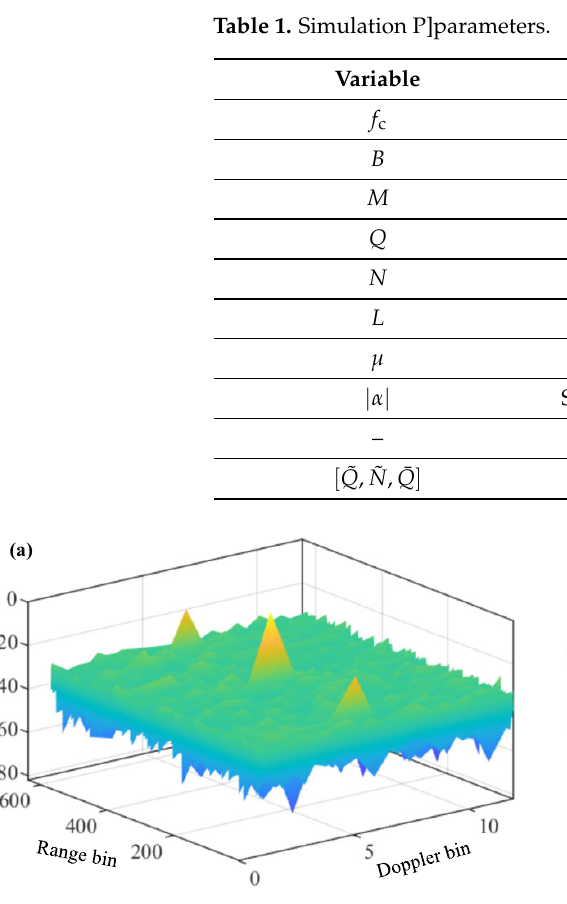
Figure 1. Illustrating the RDMs of UFS ( a ) and COS ( b ). Please note that the symbol “-” before all numbers, as automatically generated by MATLAB during plotting the figure, denotes the nega- tive